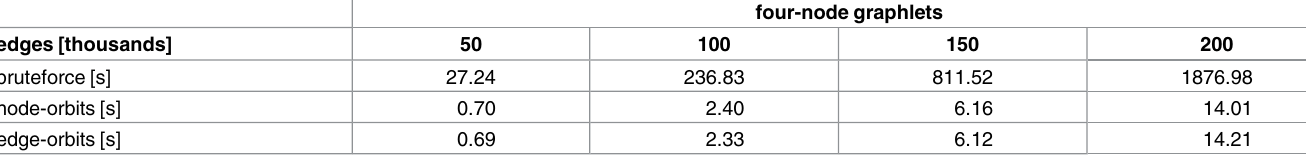
Table 2. Comparison of run times for counting node- and edge-orbits of 4-node graphlets.